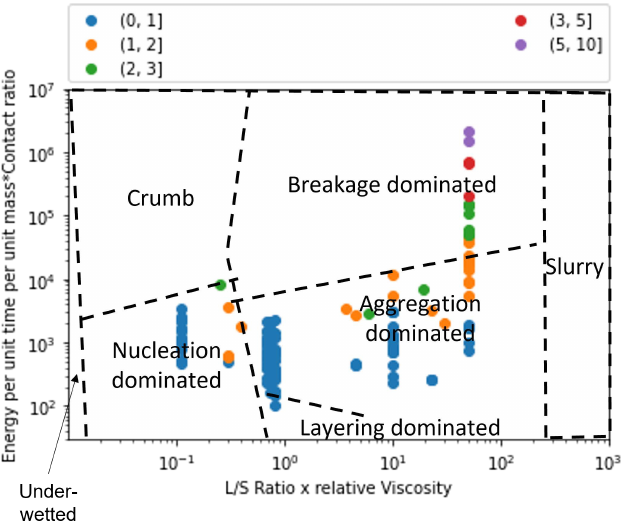
Figure 10. The regime map developed with proposed boundaries and each point colored according contact ratio of the